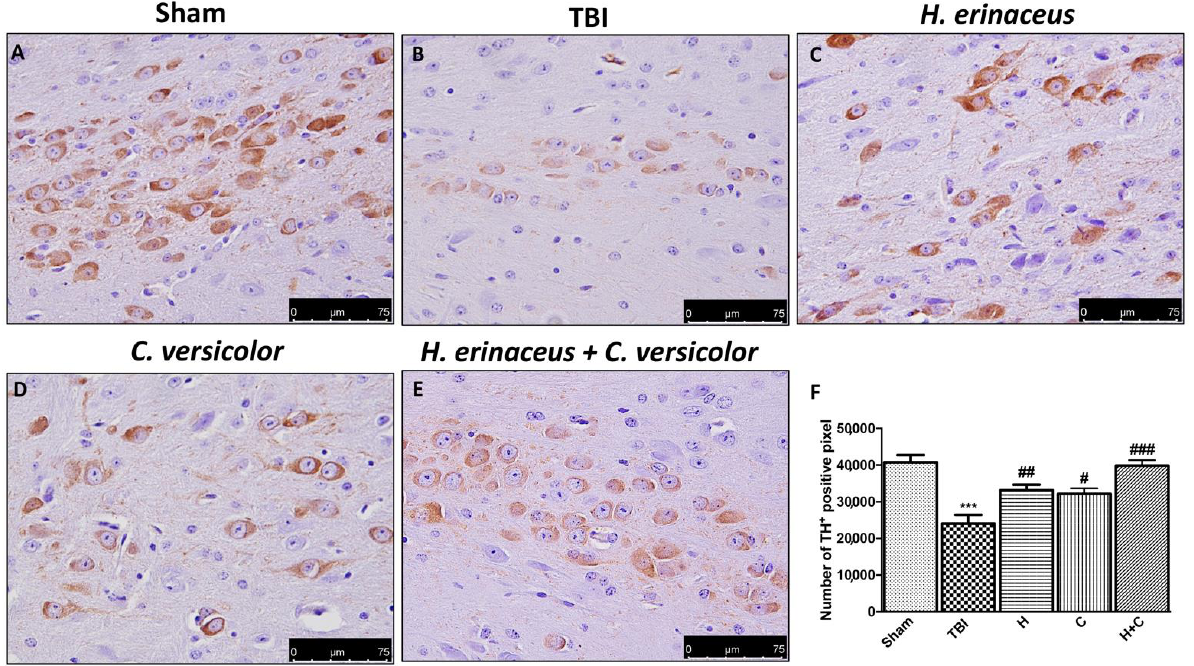
Figure 12. Effect of H. erinaceus or C. versicolor , or H. erinaceus + C. versicolor treatment on TH expression after chronic TBI. Immunohistochemical analysis on midbrain region showed a significant loss of TH-positive cells ( B ) compared to Sham mice ( A ). Animals treated with H, C and especially with H + C revealed an increase in the expression of TH ( C – E ). Data is expressed as % TH-positive pixels and are the SEM means of n = 5 mice/group. ( F ) *** p < 0.001 vs. Sham; ## p < 0.01 vs. TBI; # p < 0.05 vs. TBI; ### p < 0.001 vs. TBI.